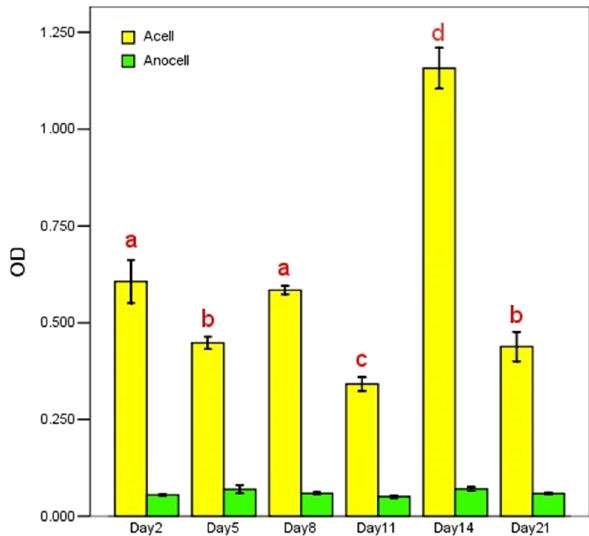
Figure 4: The alginate hydrogel beads with ( A - cell ) or without ( A - no cell ) MC3T3 - E1 cells were cultured in vitro and the OD values are shown. Groups with di ff erent letters, a, b, c, and d, were signi fi - cantly di ff erent ( P < 0.001 ) . Groups with the same letter were not signi fi cantly di ff erent ( P > 0.05 )